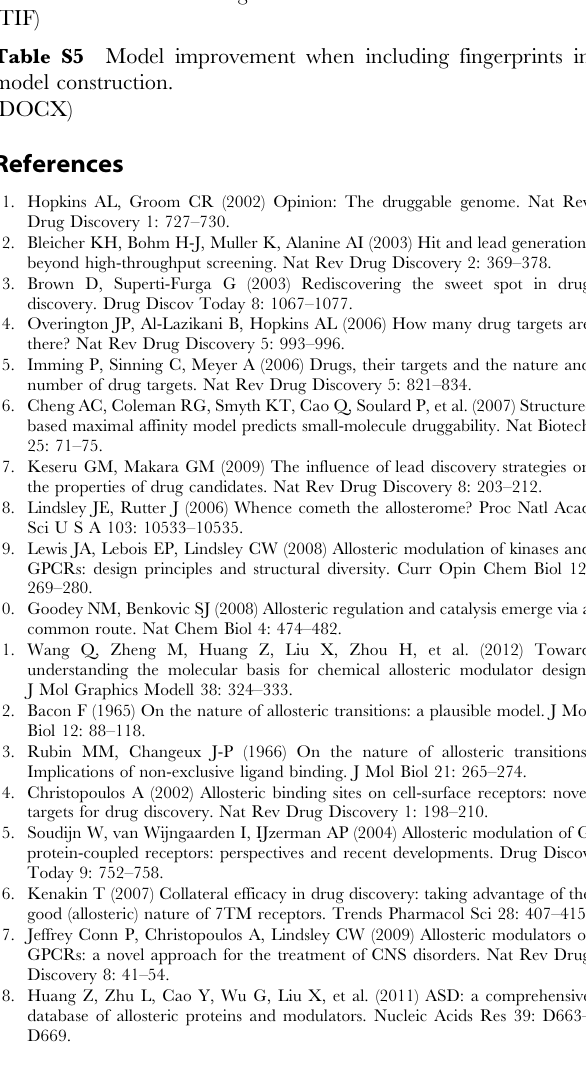
Table S6 Allosteric models for balanced data sets of L0, L1, and L2 groups. (DOCX) Table S7 Top 20 property importance for the optimized HIV RT model. (TIF) Table S8 Top 20 property importance for the optimized adenosine model. (TIF) Table S9 Top 17 property importance for the optimized protein kinase B model. Table S10 Keywords used to retrieve the allosteric